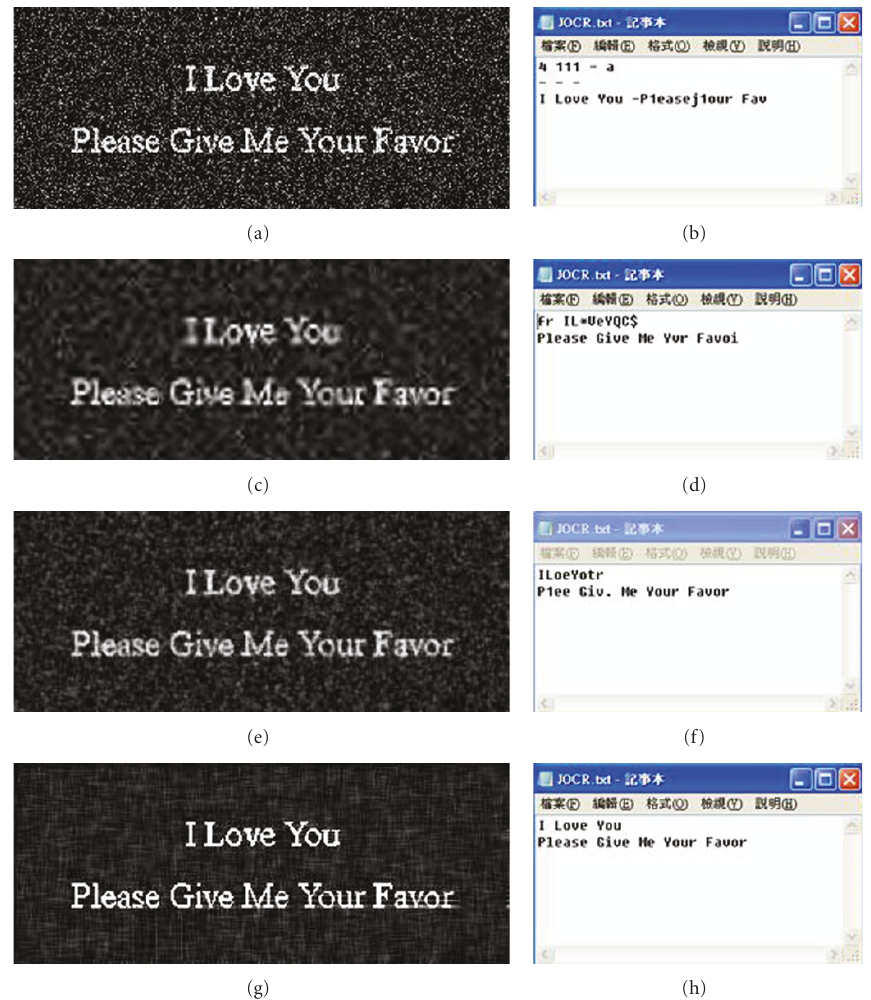
Figure 13: Left column is (a) noisy image and denoised image by (c) wavelet (e) ADF and (g) the proposed procedure, right column. (b), (d), (f), and (h) are OCR results.